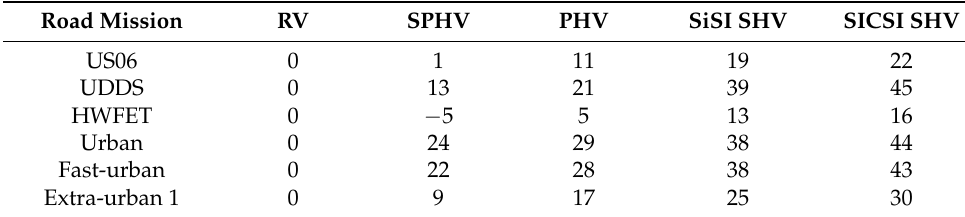
Table 13. Fuel consumption reduction (%).